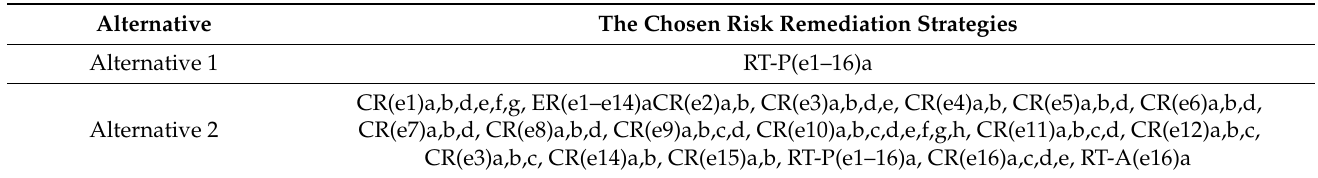
Table 7. Analyzed alternatives of the risk treatment strategies for the passive building